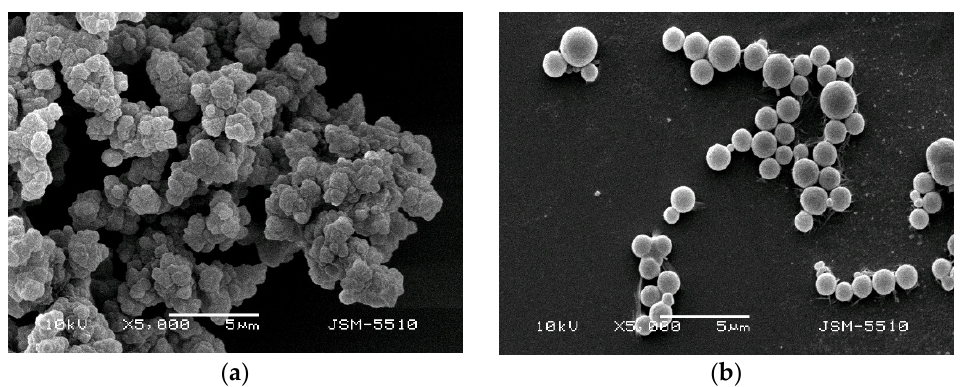
Figure 2. Scanning electron micrograph of prepared copolymer gels at a × 5000 magnification: ( a ) U(VI)–IIP; ( b )